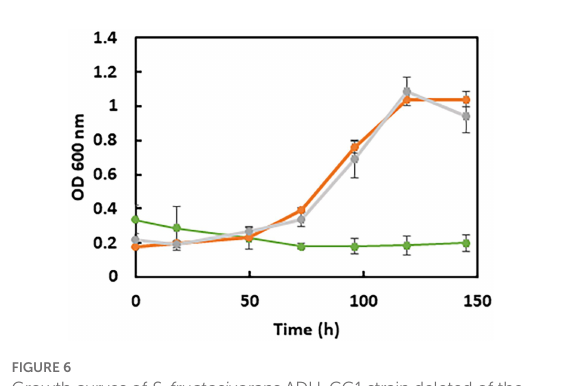
FIGURE 5 Aor level in S. fructosivorans under pyruvate and ethanol conditions. (A) Relative Aor level determined by quantitative proteomics. S. fructosivorans WT and SM4/pBGhnd6 strains were grown with pyruvate (PS2) or ethanol (ES20) as carbon source and cells were collected at stationary phase of growth. Data represent the averages of the results of three experiments. Error bars correspond to standard deviations. (B) Relative expression of the aor (DesfrDRAFT_2487) gene quantified by RT-qPCR. S. fructosivorans WT strain was grown with pyruvate (PS2) or ethanol (ES20) as carbon source and samples were collected at stationary phase of growth. Expression of the gene was normalized to that of the 16S rRNA gene. Data represent the averages of the results of three experiments. Error bars correspond to standard deviations.